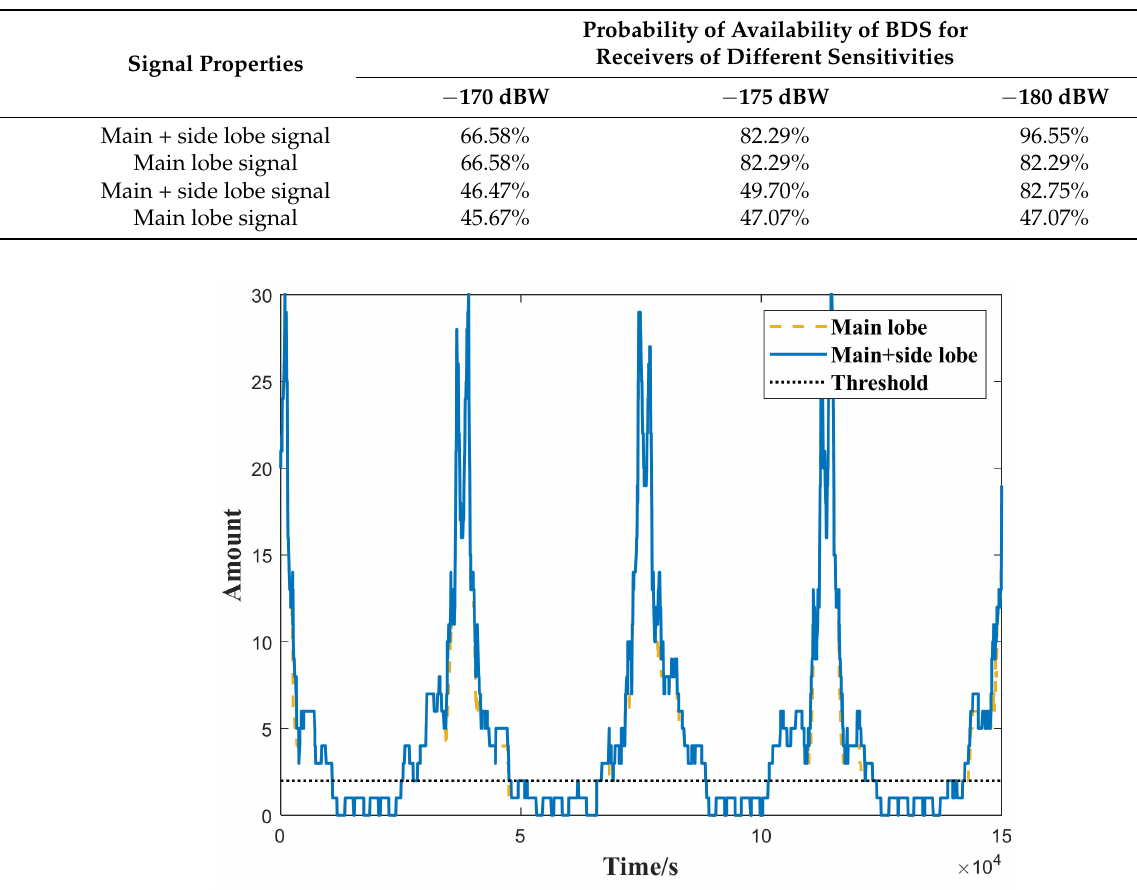
Figure 5. Visibility of GTO satellites to BD satellites when the receiver sensitivity is − 170